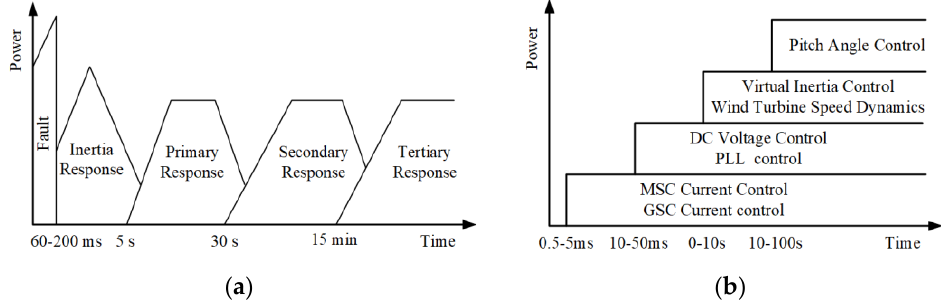
Figure 5. Transient response timescales of interest: ( a ) power system; ( b ) D-PMSG system.